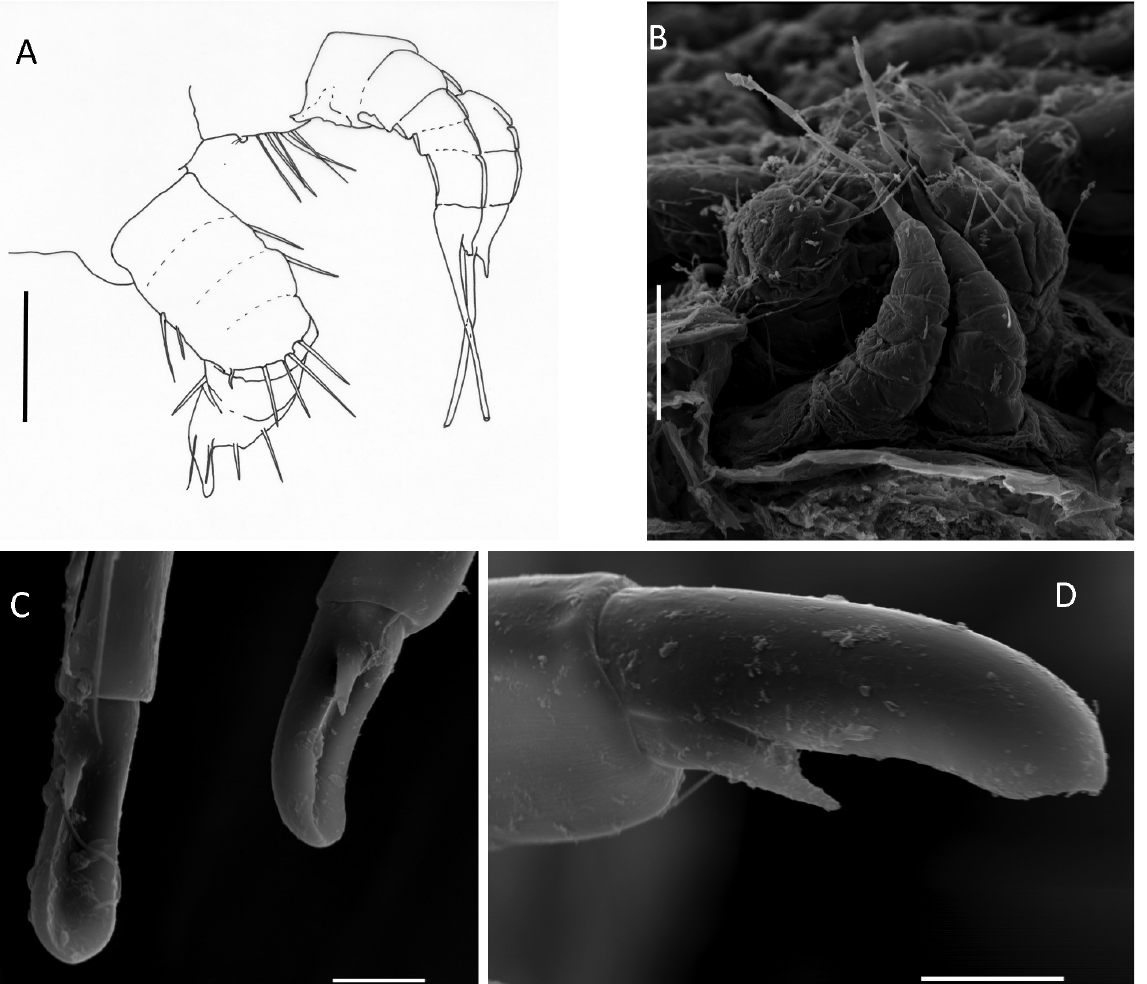
Fig. 6. Siphonophora setaepromissa sp. nov., non-type specimen. A . Male gonopods in situ. B . Male gonopods in situ. C . Claws in ventral view. D . Claw in anterior view. Scale bars: A –B = 100 µm; C–D = 10